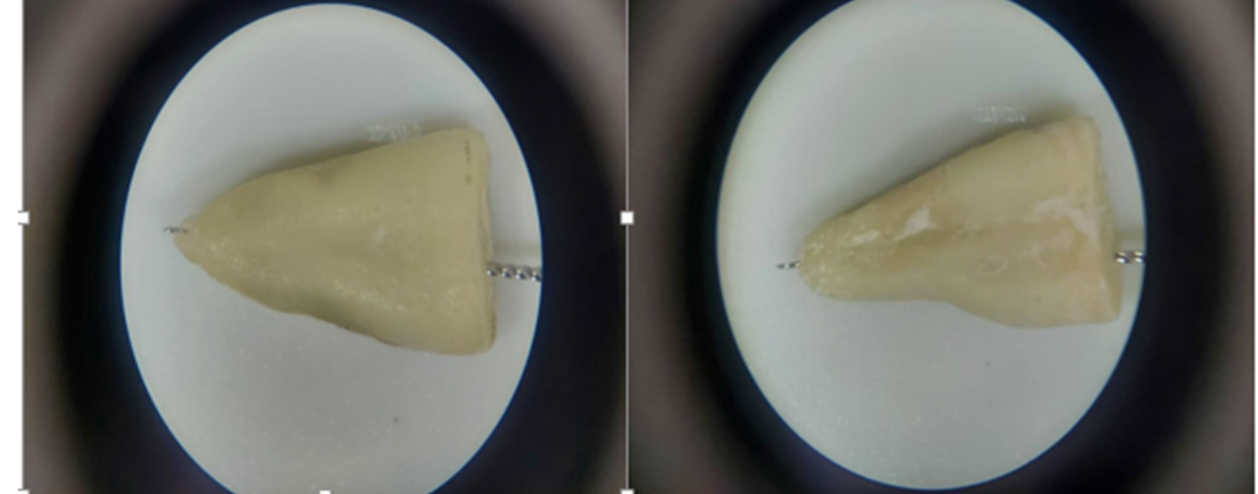
Figure 1. ( Left ) A tooth with lateral apical foramen; ( Right ) A tooth with central apical foramen.